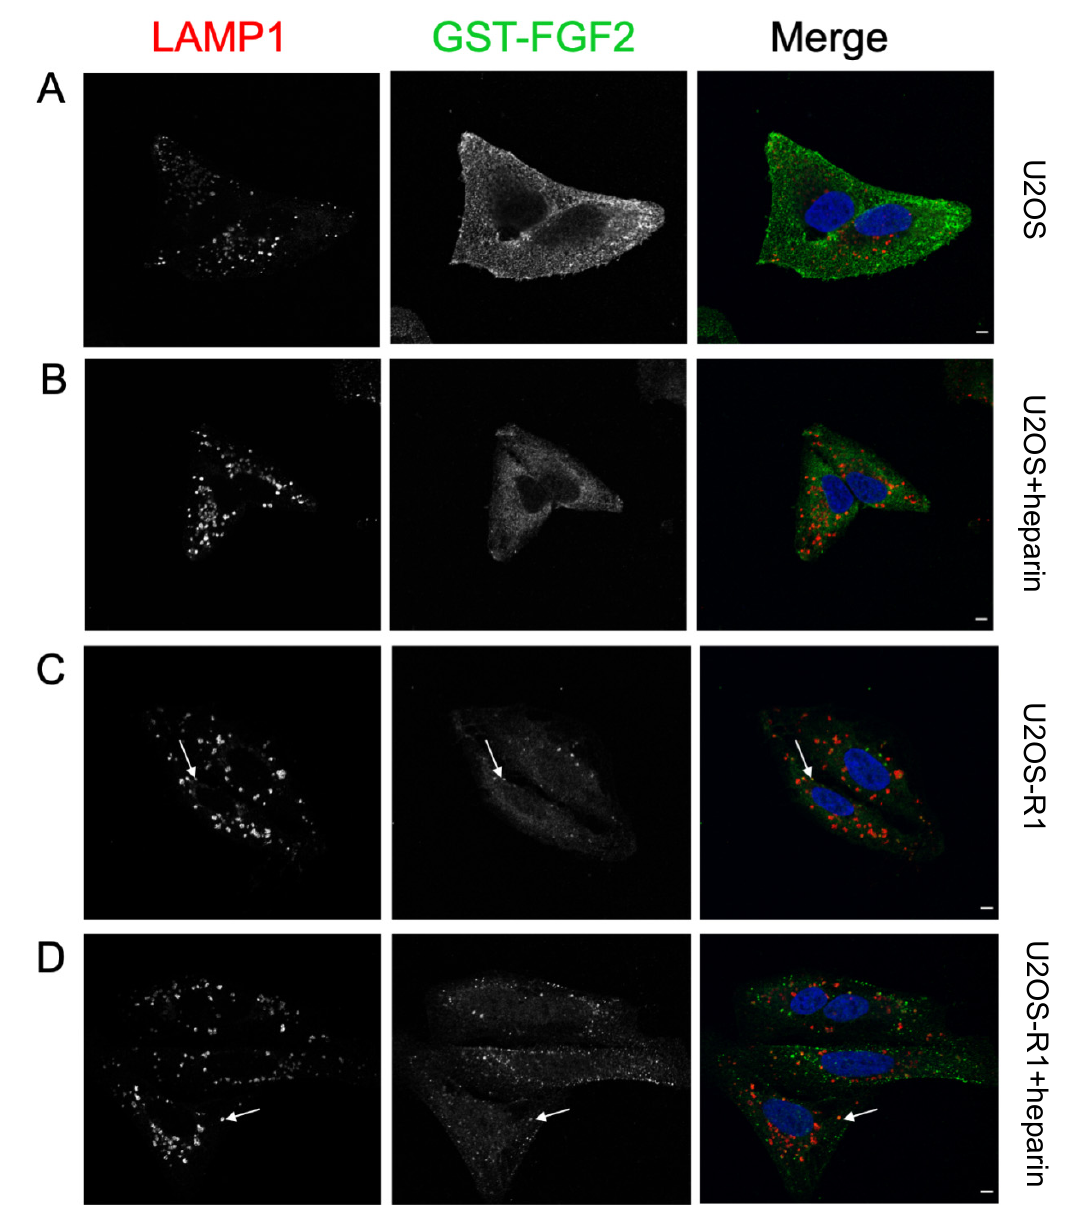
Figure 6. Localization of LAMP1 and GST-FGF2 in U2OS and U2OS-R1 cells. ( A – D ) Cells were incubated with CQ for 1 h, prior to a 4 h incubation with 100 ng/mL GST-FGF2 + / − 20 U/mL heparin at 37 ° C, 5% CO 2 . Cells were then fixed and stained for LAMP1 (red), GST-FGF2 (green) and nucleus (blue). ( A ) U2OS − Heparin ( B ) U2OS + Heparin ( C ) U2OS-R1 -Heparin ( D ) U2OS-R1 + Heparin. Arrows point to examples of colocalization. Scale bar, 5 μ m. Images from one representative experiment (out of three) are presented.